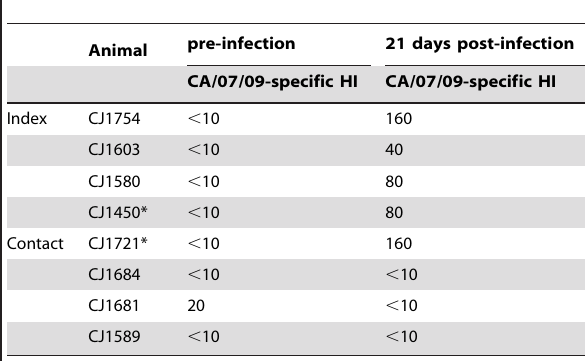
Table 1. Anti-CA/07/09 serum antibody titers.